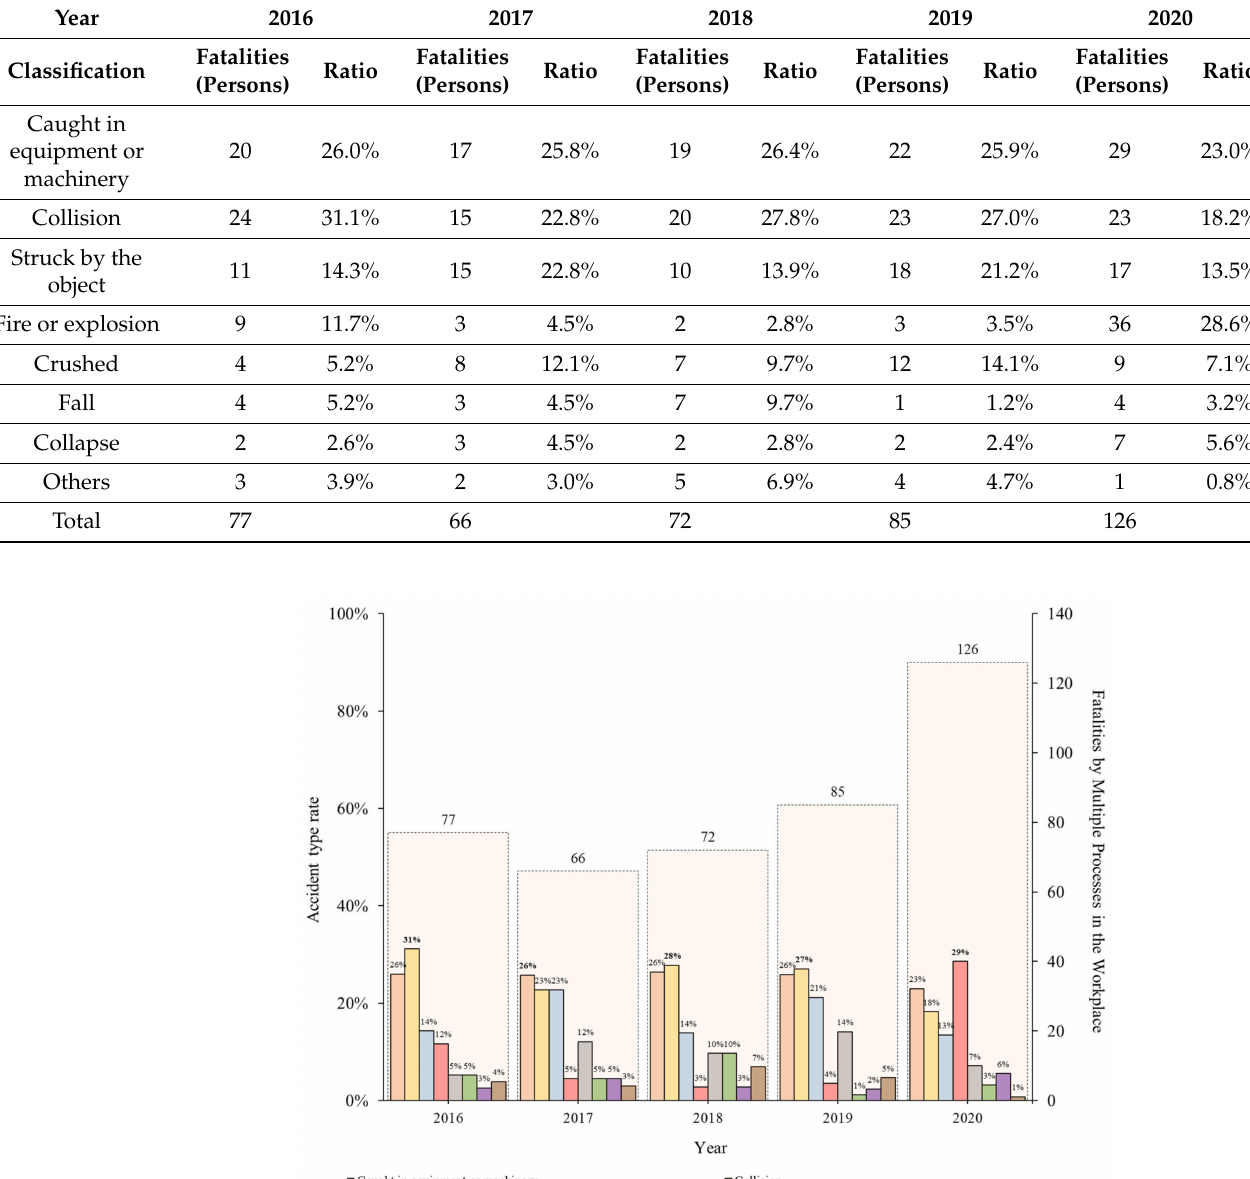
Table 7. Fatalities and ratio based on the accident type caused by multiple processes in the workplace.